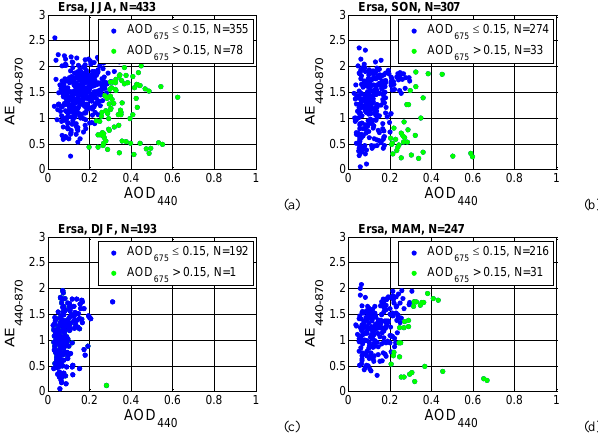
Figure 2. Ångström exponent calculated between 440 and 870nm (AE 440 − 870 ) as a function of the aerosol optical depth at 440nm (AOD 440 ) at Ersa during (a) summer, (b) autumn, (c) winter and (d) spring, for the whole 2011–2015 AERONET level 2.0 daily AOD dataset. Blue bullets are for AOD 675 <0.15 and green bul- lets for AOD 675 >0.15. In this figure and in the rest of the paper N represents the number of points or observations shown in the plot or used to calculate the means shown in the plot.